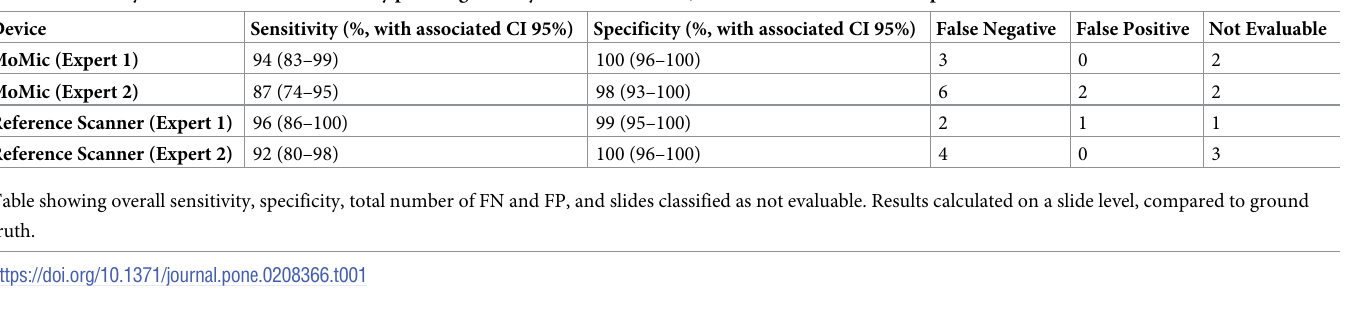
Table 1. Accuracy for detection of metastases by pathologist analysis of virtual slides, scanned with both microscope scanners. Device